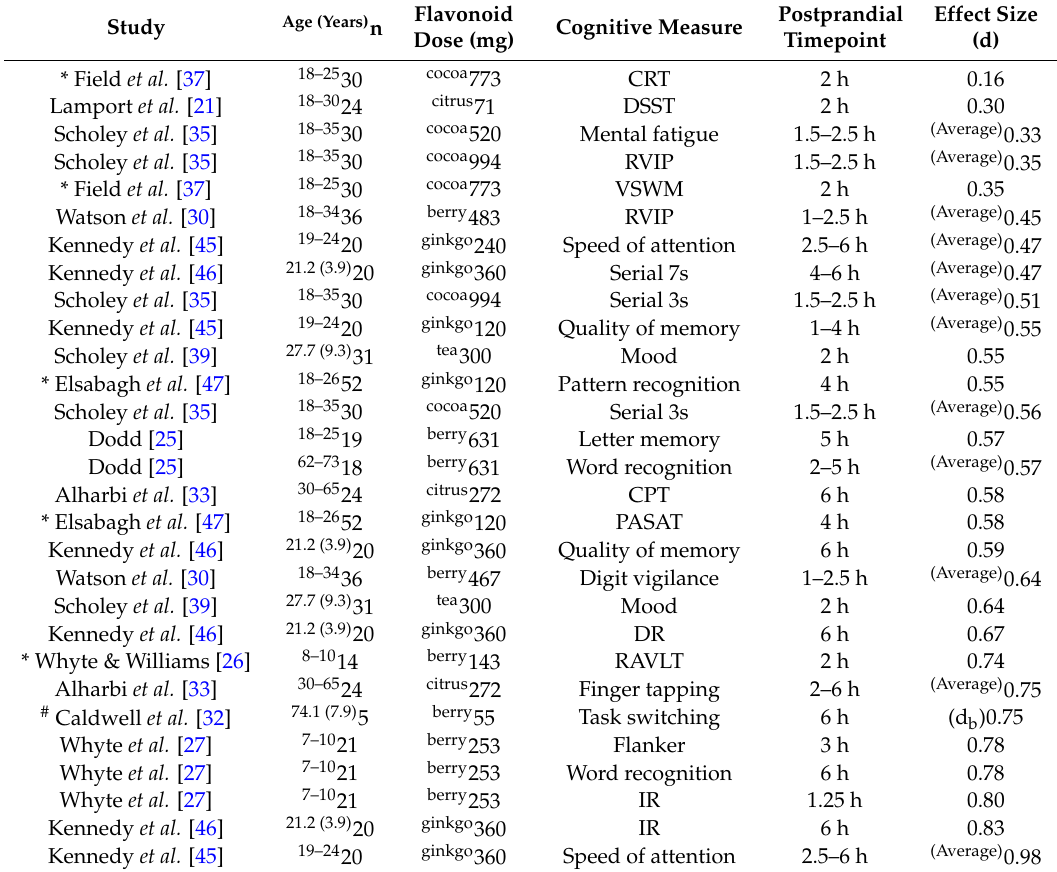
Table 3. A summary of statistically significant cognitive outcomes in ascending order of effect